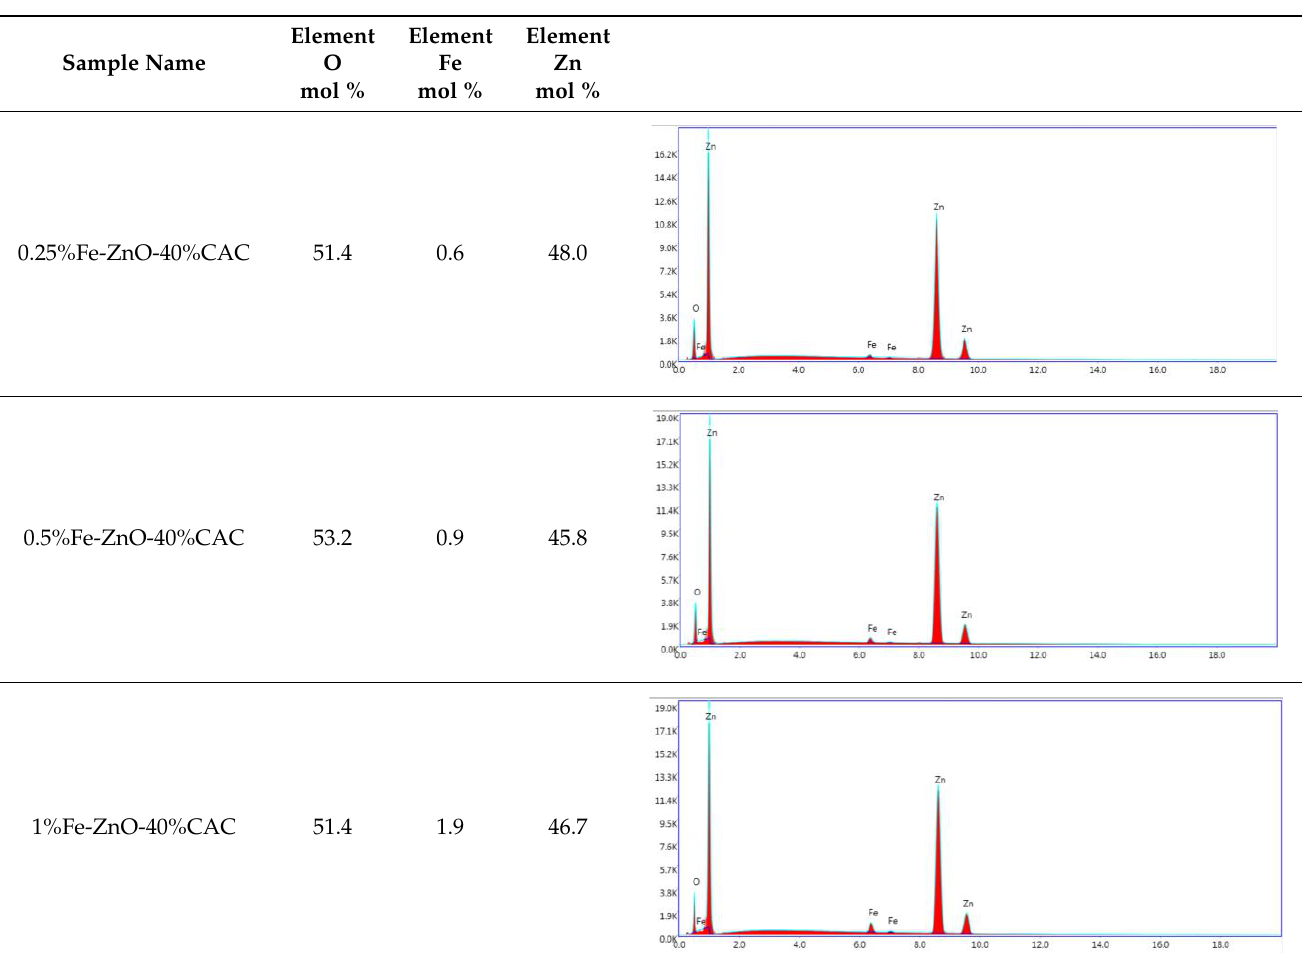
Table 2. EDX data for x%Fe-ZnO-40%CAC